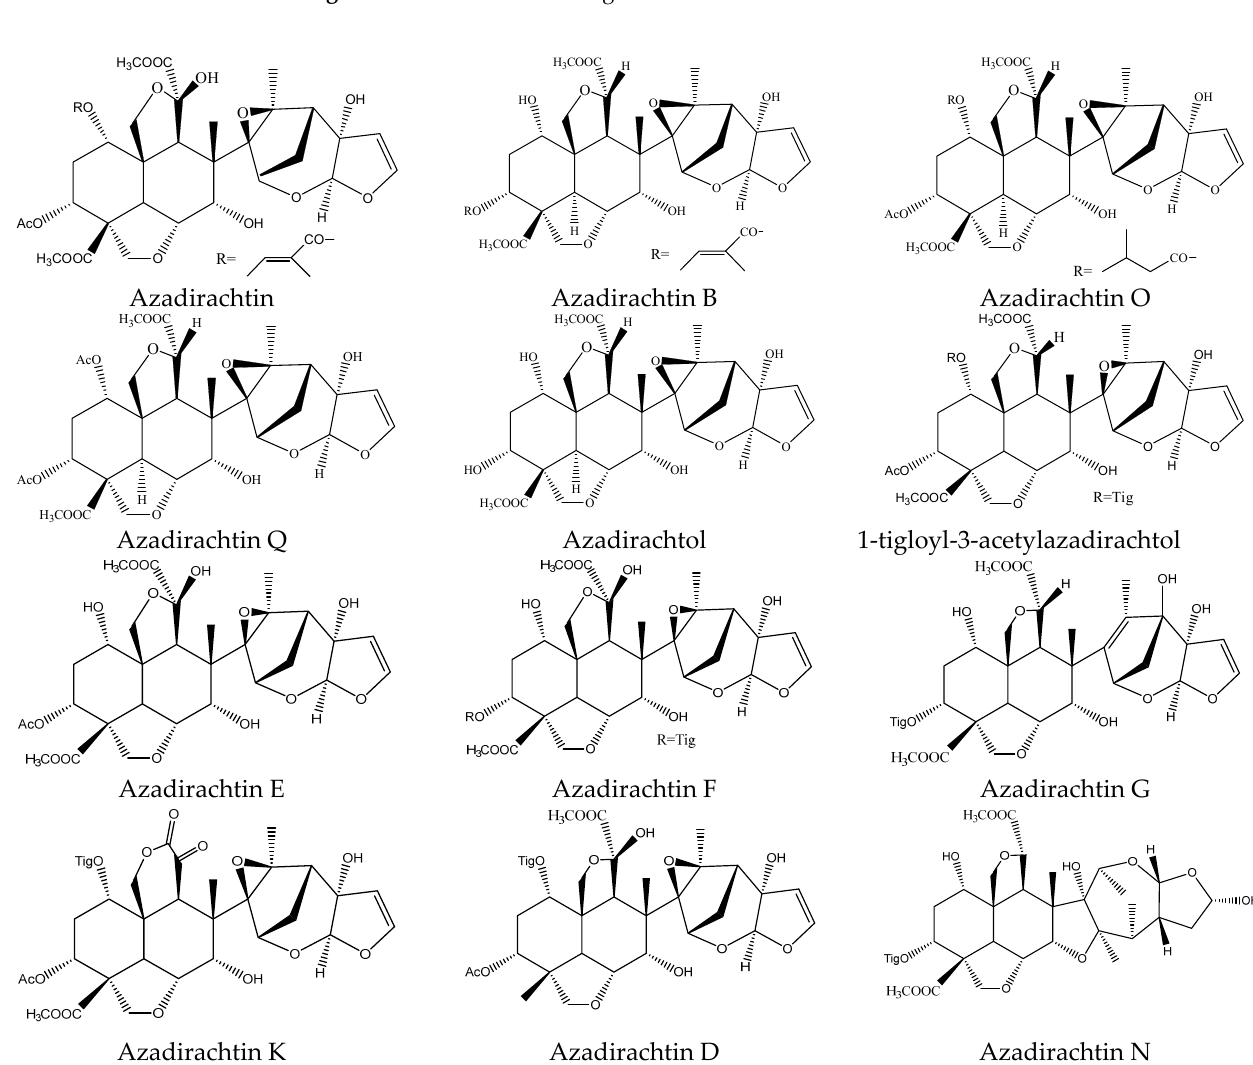
Figure 6. The structures of azadirachtin/meliacarpin-class chemicals.